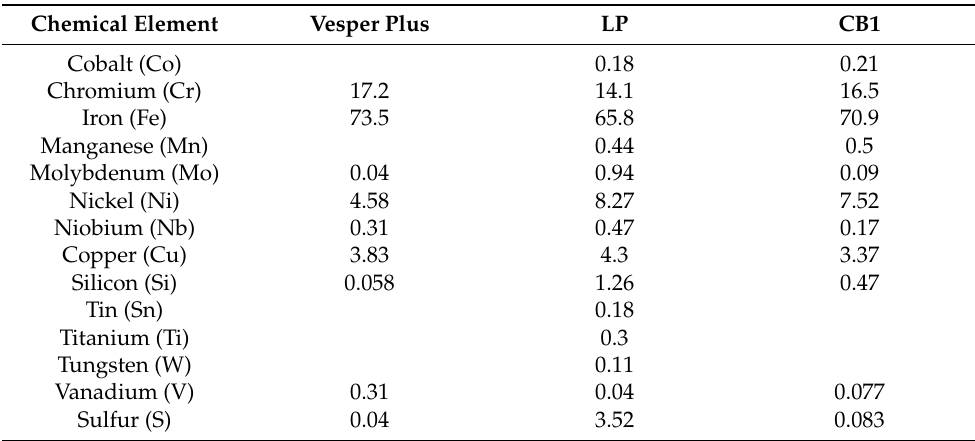
Table 11. Conventional brackets overall